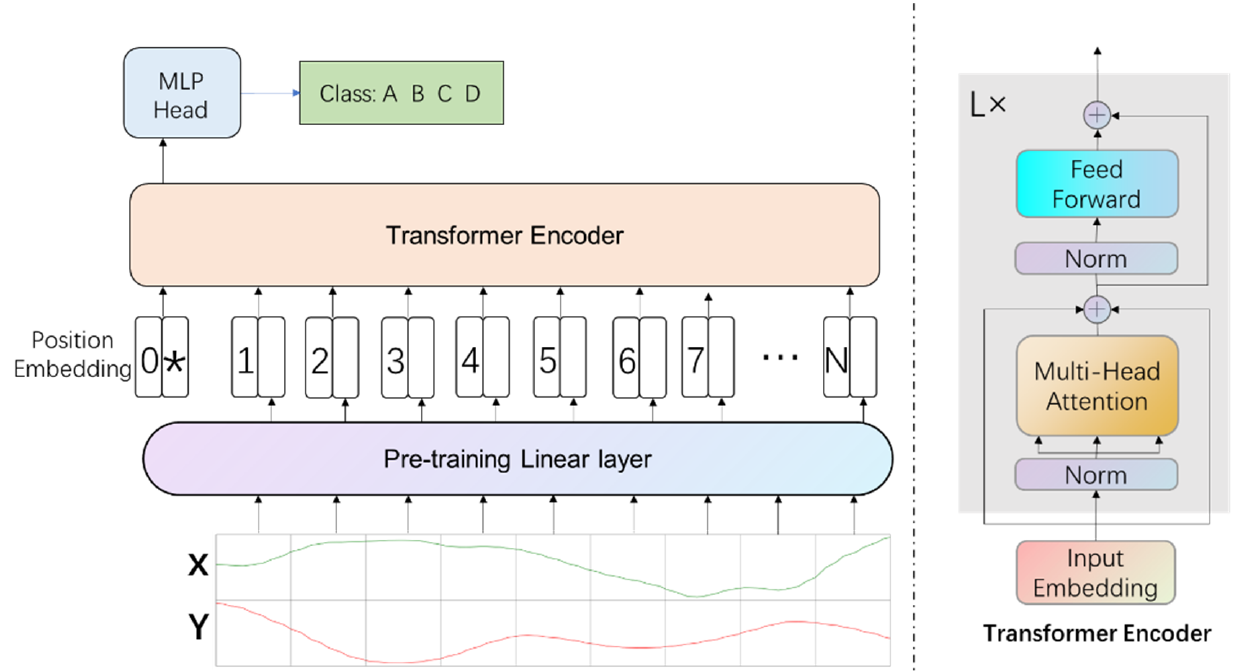
Figure 4. The detailed architecture of our proposed Transformer.